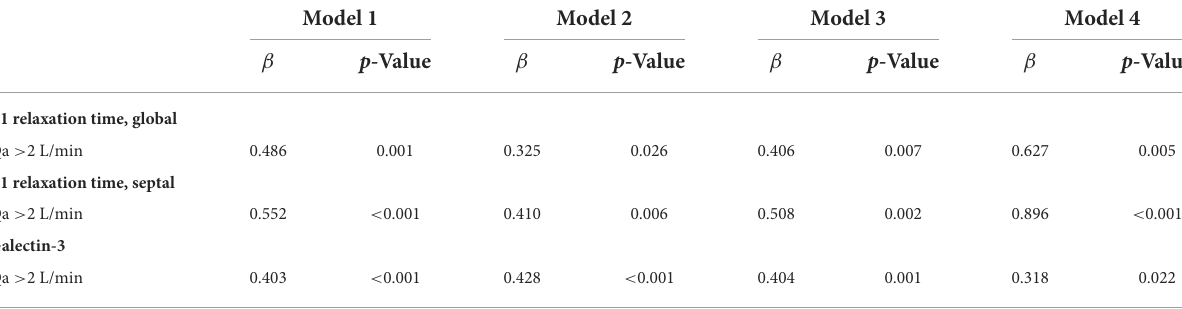
TABLE 4 Adjusted association between a high flow AVF and the risk of myocardial fibrosis in HD